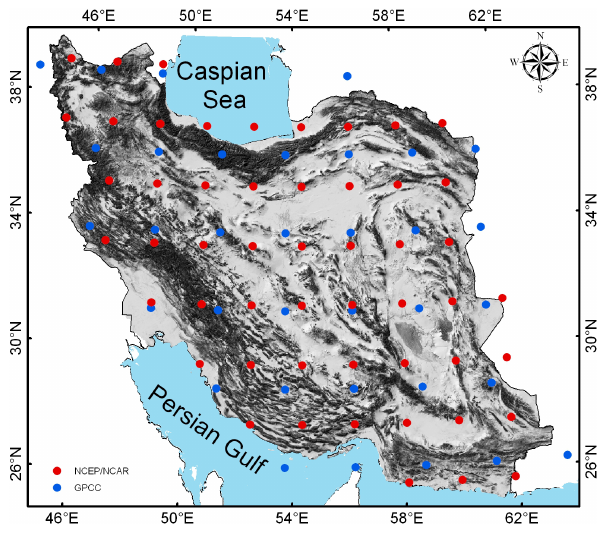
Fig. 1. Map of Iran with orograghy. Red bullets are NCEP/NCAR grid points and blue bullets GPCC grid